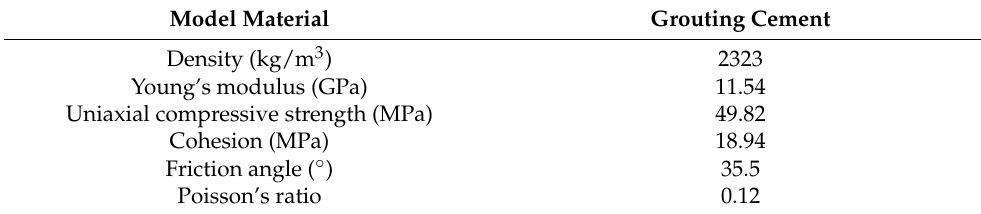
Table 2. Test conditions.